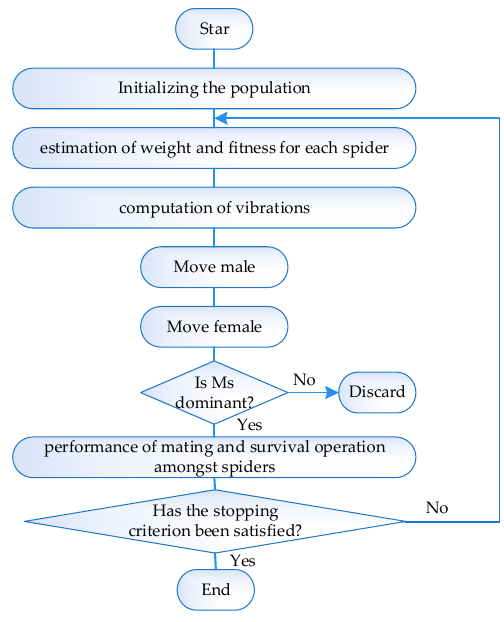
Figure 2. Flowchart of SSO algorithm.